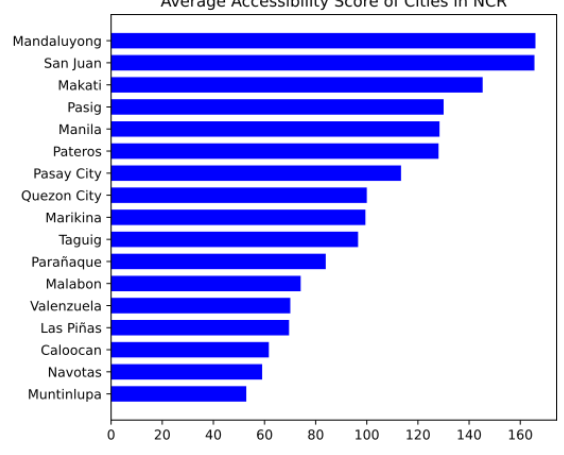
Figure 5 : Average Amenity Accessibility Score